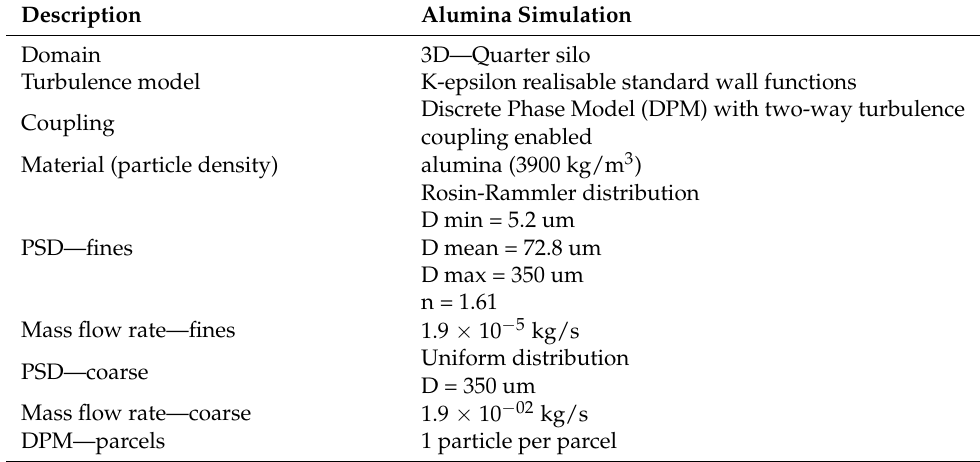
Table 1. Simulation